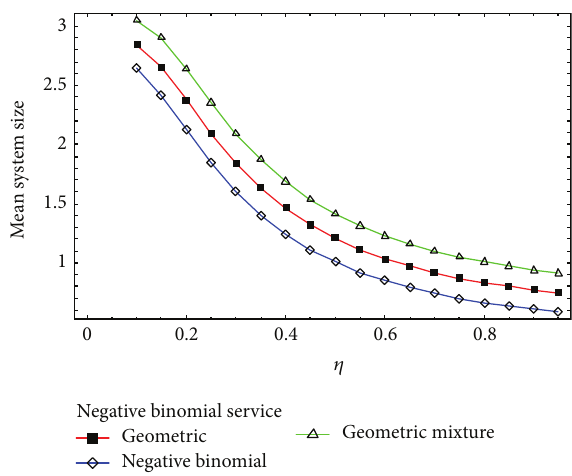
Figure 4: Mean system size over 𝜂 with various repair time